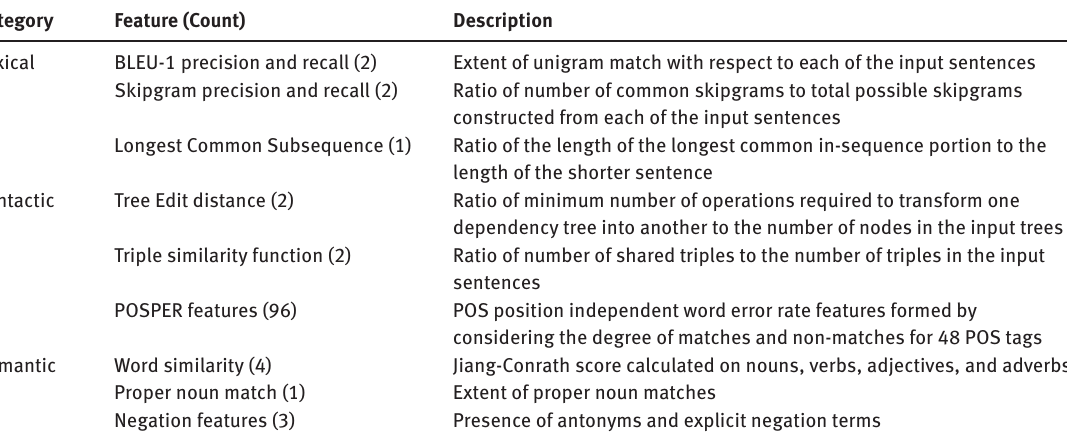
Table 1: Paraphrase Recognition